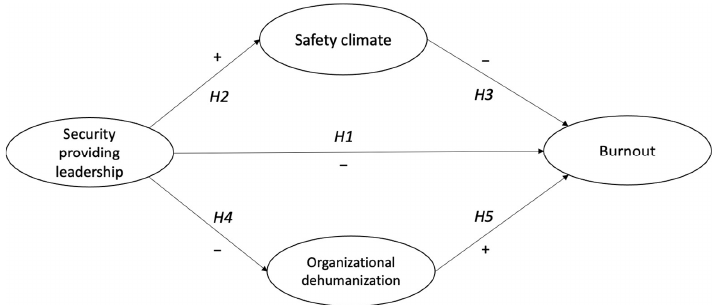
Figure 1. Theoretical model and hypotheses.